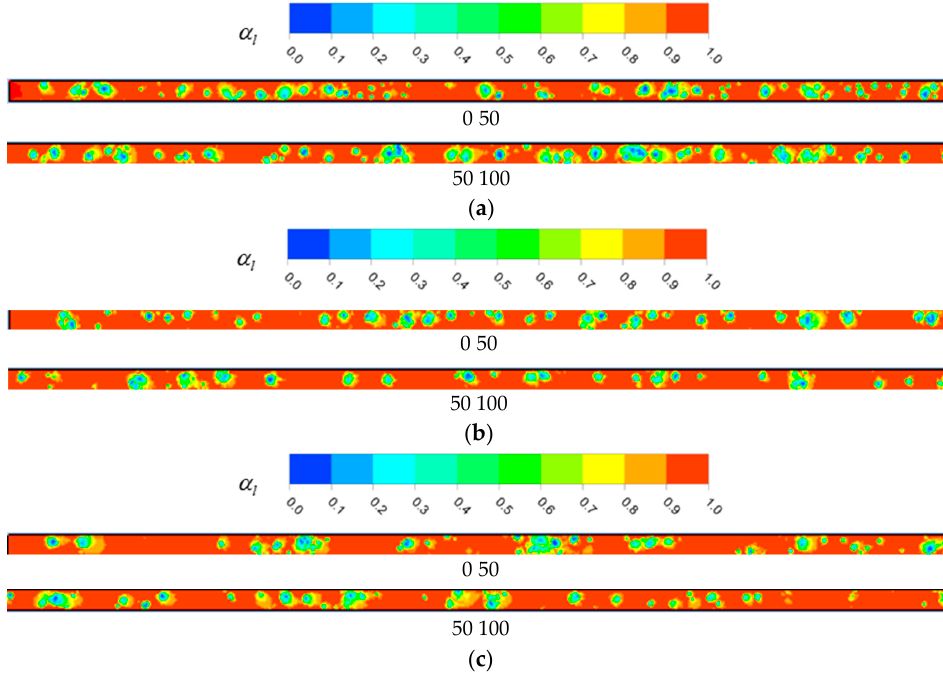
Figure 4. Volume fraction distribution of R744 liquid phase at different mass fluxes: ( a ) T sat = 253 K, G = 50 kg/m 2 · s, q = 10 kW, X = 0.28; ( b ) T sat = 253 K, G = 75 kg/m 2 · s, q = 10 kW, X = 0.19; ( c ) T sat = 253 K, G = 100 kg/m 2 · s, q = 10 kW, X = 0.14.